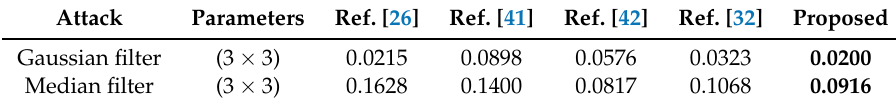
Table 4. The average BER comparison with PSNR = 42 dB under filtering attacks.